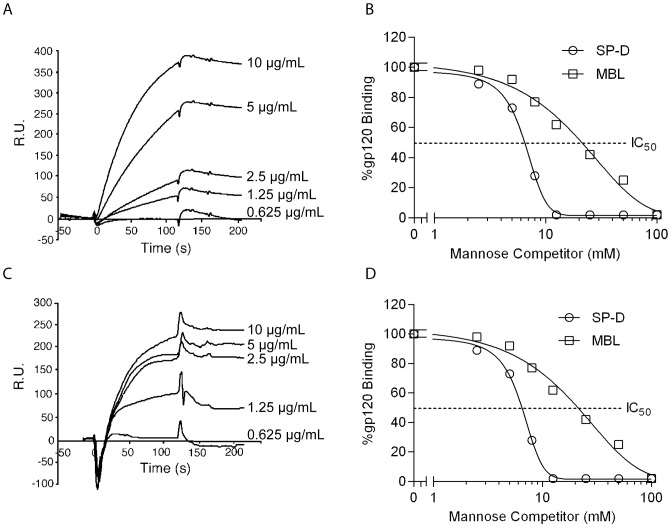
Competition of SP-D binding to gp120 by hexoses.
A: Surface plasmon resonance response showing the binding of SP-D to biotinylated recombinant gp120 IIIB immobilized on a streptavidin chip. Each trace indicates the response units recorded at a given concentration of SP-D (10, 5, 2.5, 1.25, and 0.625 µg/mL) in 5 mM CaCl2-containing (HSC) buffer (traces are in order of the highest to lowest concentration). B: Competition of SP-D (5 µg/mL) binding to gp120 with hexoses. The effect of different concentrations of hexoses in competing with gp120 for SP-D binding. The IC50 values were as follows: maltose; 6.5 mM>mannose; 7.8 mM>>GlcNAc; 22.9 mM>D-galactose; 32.2 mM. Dotted line shows IC50. C: Competition of SP-D binding to mannan with gp120. The effect of different concentrations of gp120 (0, 1.625, 3.125, 6.25, and 12.5 µg/mL) on the binding of SP-D (5 µg/mL) to mannan was determined by the changes in the response units. An increase in the gp120 concentration results in a decrease in the surface plasmon resonance response. D: Competition of gp120 binding for SP-D and MBL to mannan. Dotted line shows IC50